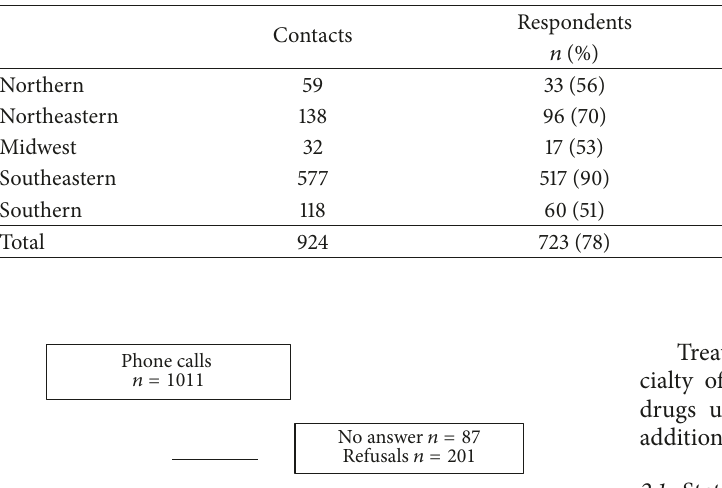
Table 1: Sample characterization by Brazilian region.